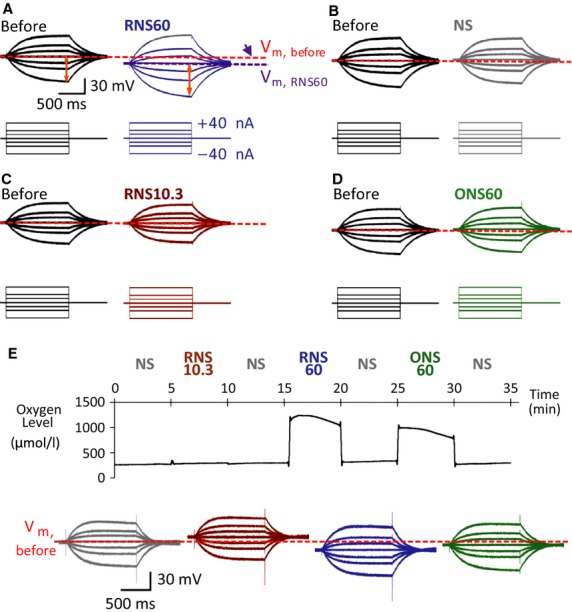
Intracellular recordings from Xenopus laevis oocytes in the presence of RNS60- (A), NS- (B), RNS10.3- (C), and ONS60- (D)-based Ringer's solutions. Note that solutions based on RNS60, but not those based on normal saline (NS), RNS10.3 (TCP-modified saline without excess oxygen), or ONS60 (saline containing comparable level of oxygen without TCP modification), increased (hyperpolarized) resting membrane potential. Also, step pulse transmembrane current injection-induced membrane potential changes were increased only in the presence of RNS60. (E) Intracellular recording with serial applications of NS, RNS10.3, RNS60, or ONS60 with measurement of oxygen level in recording solutions.